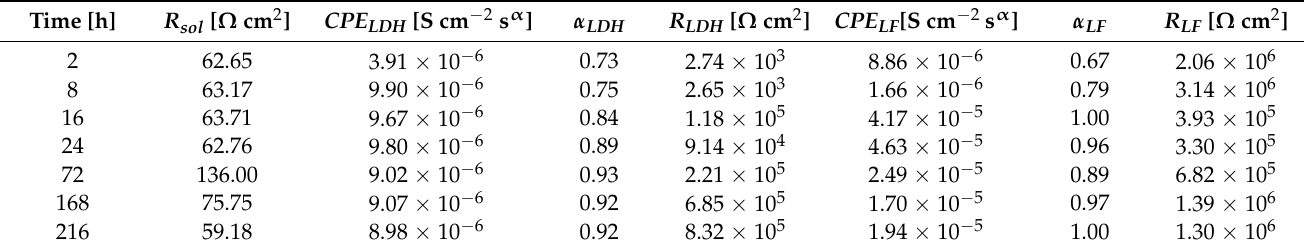
Table 2. Results of EIS fitting for C10-1 sample.